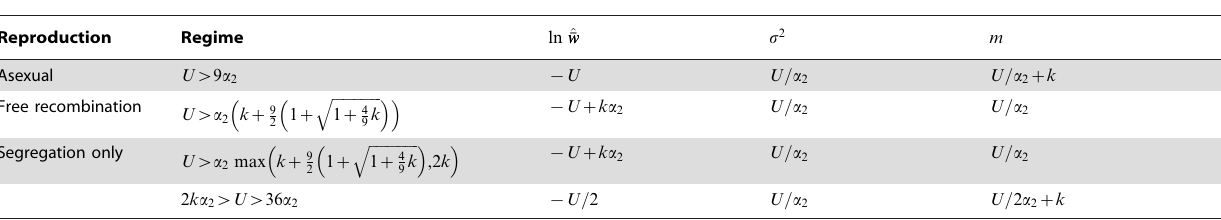
Table 1. Hidden epistasis when a 1 ~ b ~ 0 .